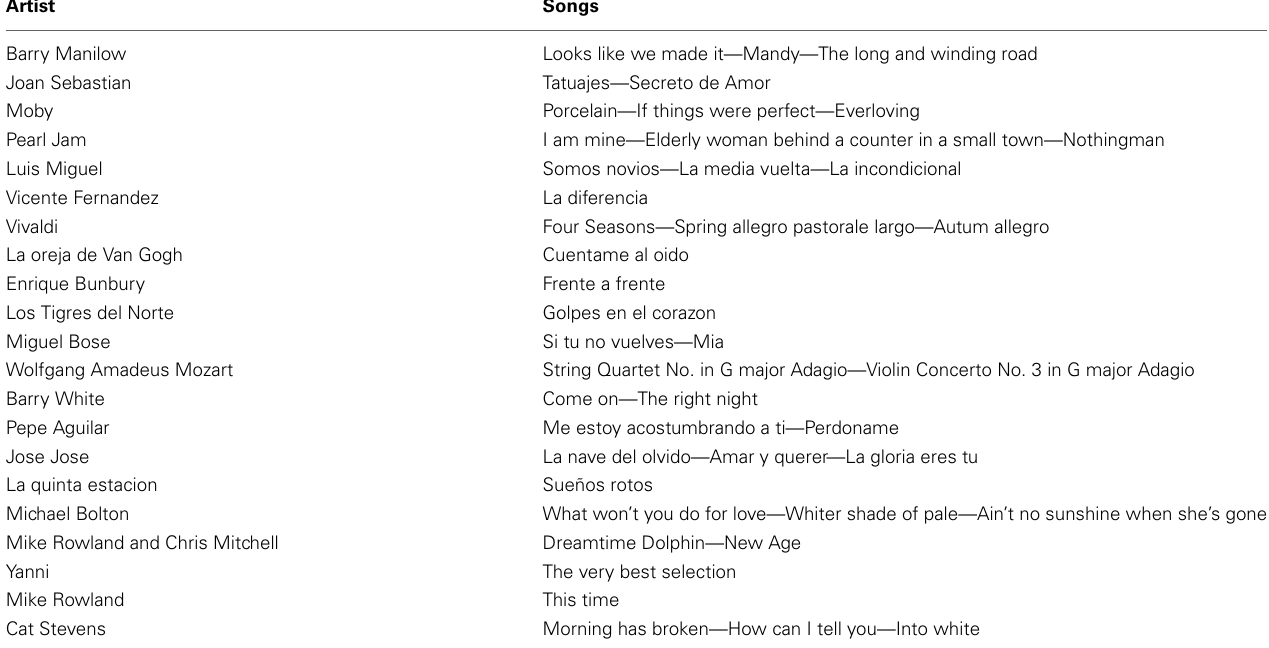
Table A2 | Music chosen by the